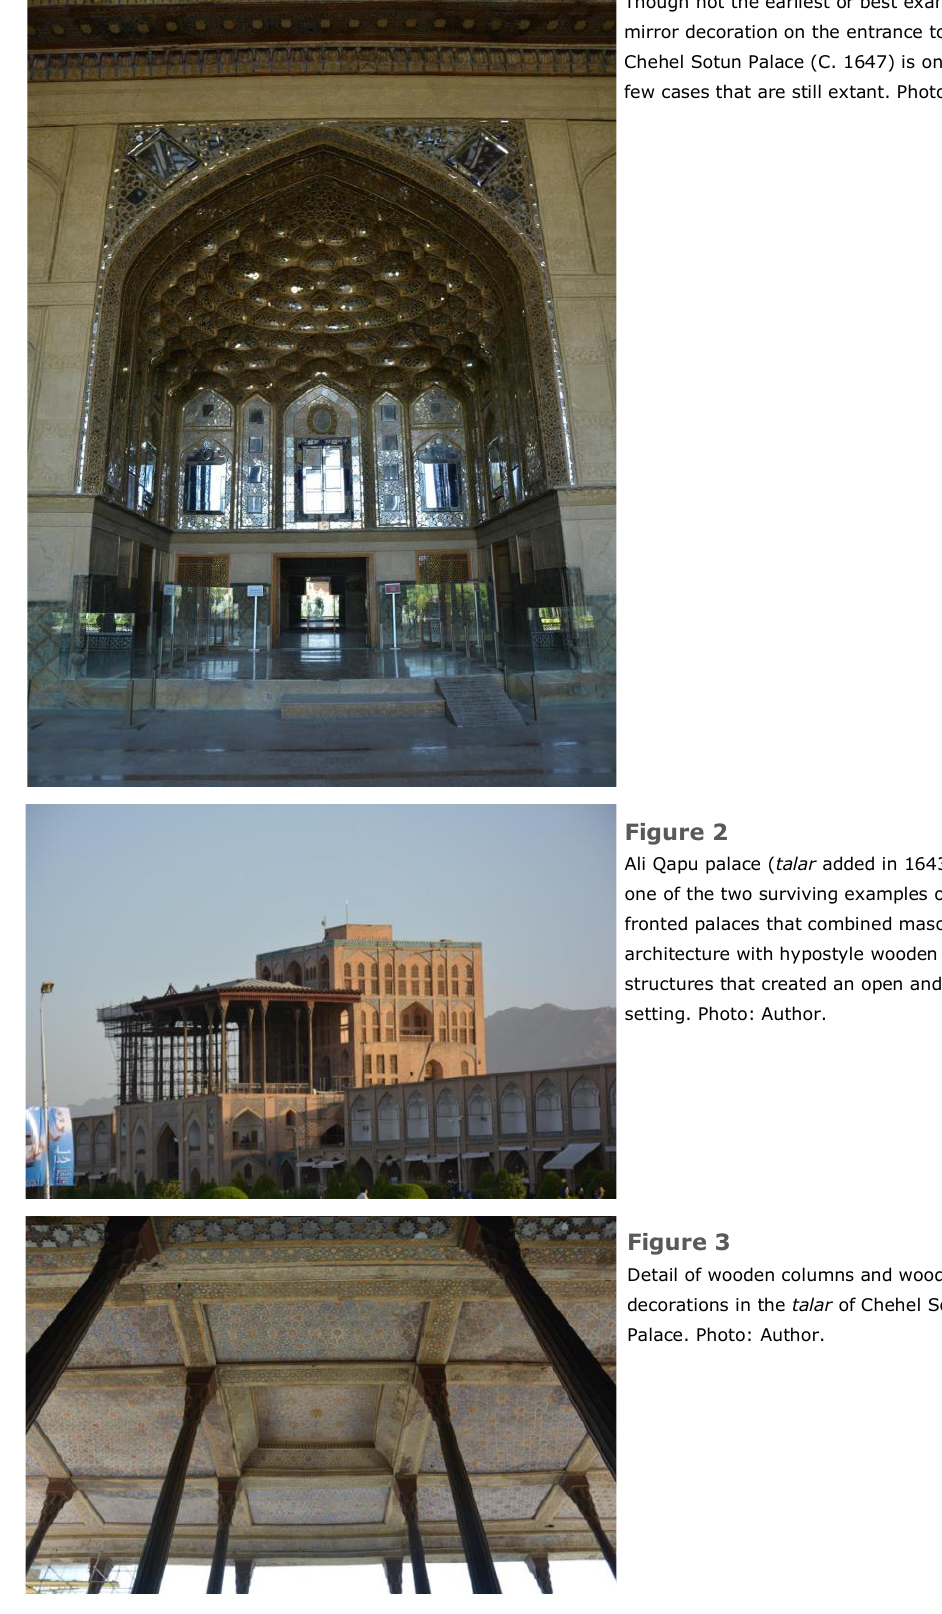
Figure 1 Though not the earliest or best example, mirror decoration on the entrance to the Chehel Sotun Palace (C. 1647) is one of the few cases that are still extant. Photo: